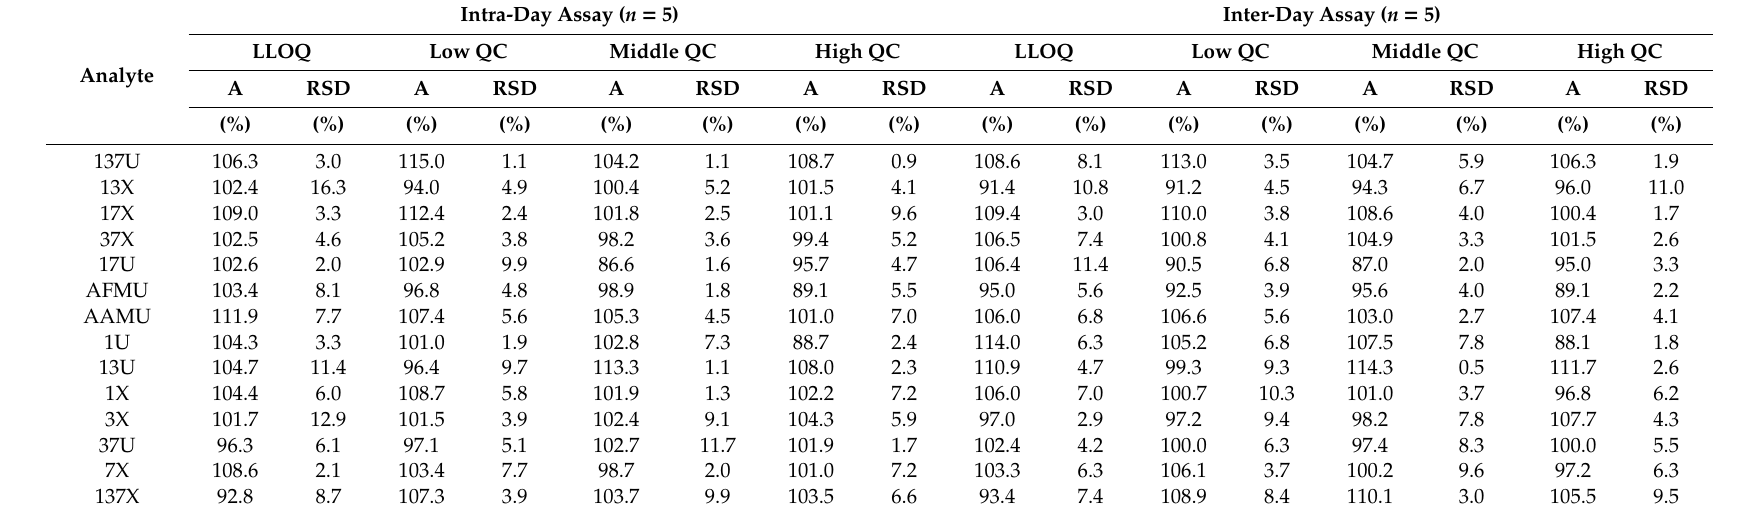
Table 1. Intra-day and inter-day accuracy (A) and precision for the determination of ca ff eine and its